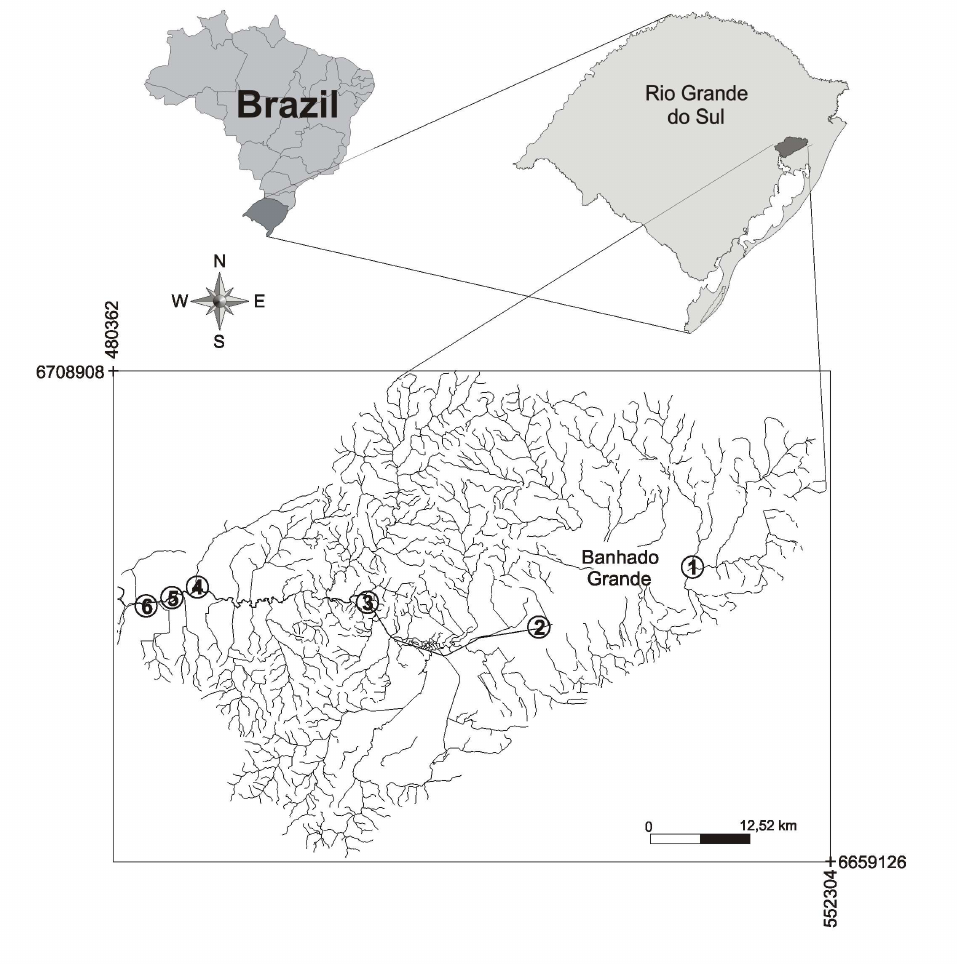
Figure 1. Location of the Gravataí River watershed, in the state of Rio Grande do Sul, and of the six sampling stations along the Gravataí River. Stations: 1 = Chicolomã stream, city of Santo Antônio da Patrulha; 2 = Juca Barcelos farm, city of Glorinha; 3 = Passo dos Negros, city of Gravataí; 4 = Pumping station, city of Porto Alegre/Canoas; 5 = Areia Stream, city of Porto Alegre/Canoas; 6 = Gravataí River mouth, city of Porto